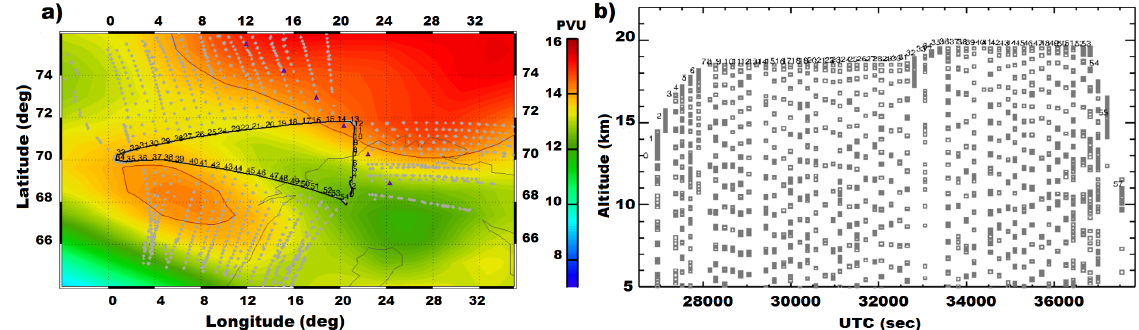
Fig. 2. (a) PV in PVU obtained from the ECMWF archive at 125hPa as a function of latitude and longitude in the flight region. Black line marks the flight track during the PrEx 1 flight, the position of MARSCHALS tangent points of each scan is shown in grey, while blue triangles represents the position of MLS/Aura scans. (b) Position of MARSCHALS measurements for band B, band C and band D with respect to altitude and time for the PrEx 1 flight.